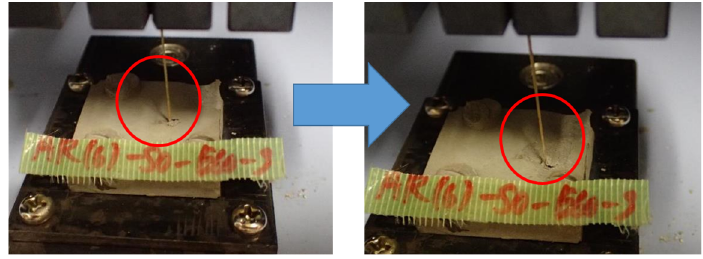
Figure 6. Example of the specimen with peeling of matrix.